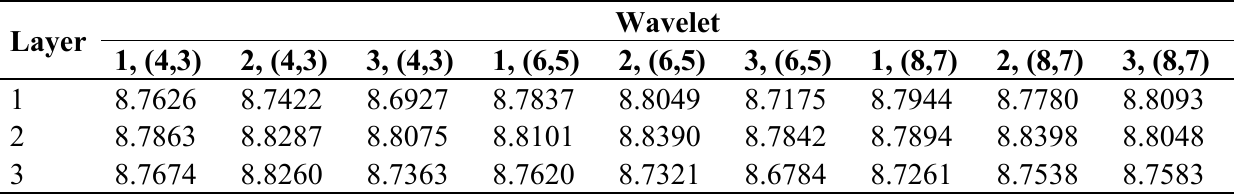
Table 3. Normalized l P norms for node signals at each layer ( × 10 29